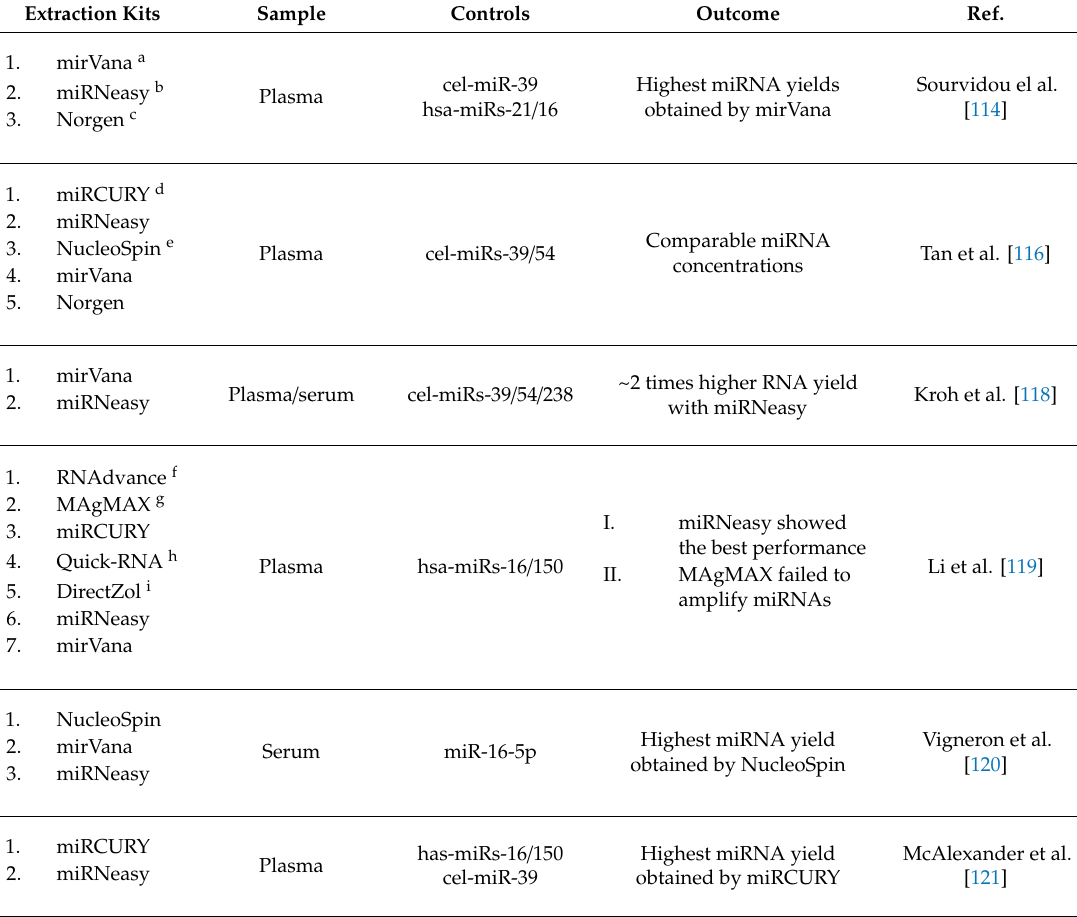
Table 4. Comparison of commercially available miRNA extraction kits by various